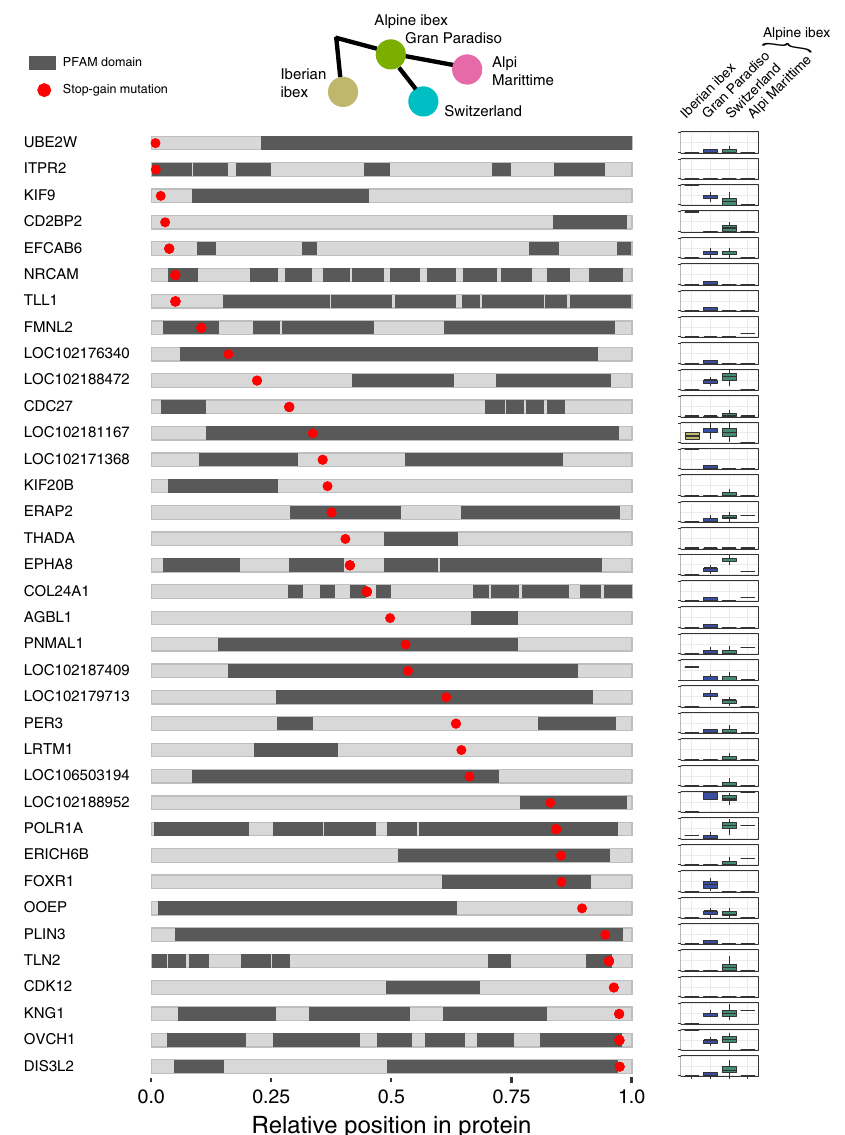
Fig. 5 Homology-based inference of the impact of highly deleterious mutations. The localization of protein family (PFAM) domains are highlighted in dark. Red dots indicate the relative position of a highly deleterious mutation segregating in Alpine ibex. The frequencies of highly deleterious mutations are summarized for Iberian ibex and three groups of Alpine ibex. Allele frequencies are shown as boxplots per group representing the outcome of downsampling to the smallest group (Alpi Marittime, n = 3) based on 100 replicates. The frequencies of highly deleterious mutations tend to be higher in Alpine ibex because mutation ascertainment was performed in this species. Box plot elements are de fi ned as in Fig. 1. Source data are provided as a Source Data fi